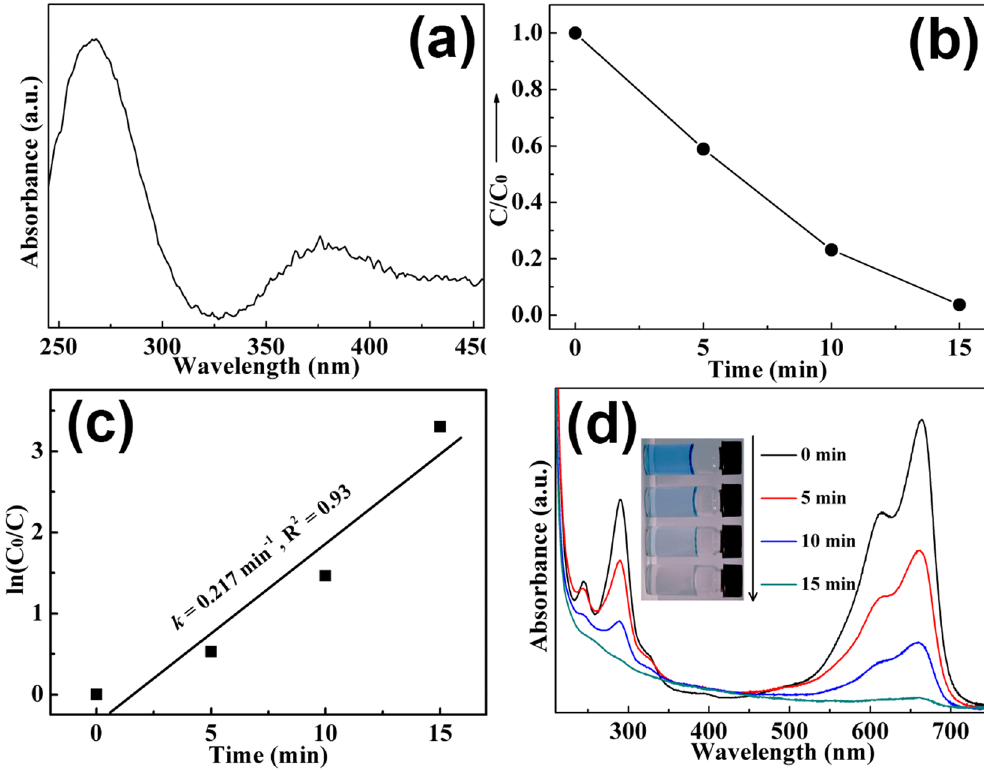
Figure 6. UV-vis spectrum ( a ) of Eu-doped calcium aluminate sample, dynamic curve ( b ), plots of ln (c 0 /c) versus time ( c ) and absorbance variations ( d ) of MB solution over Eu-doped calcium aluminate